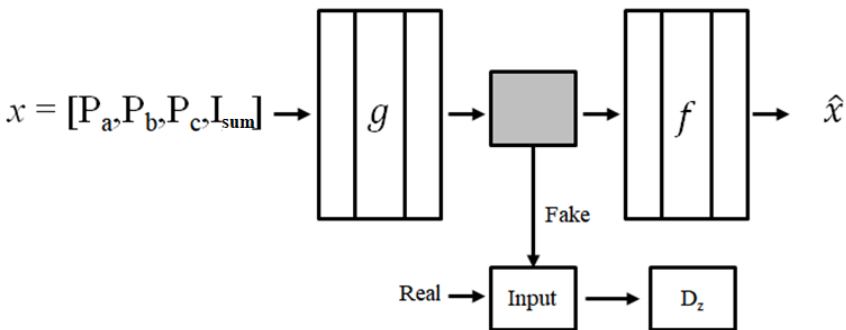
Figure 3. Graphical illustration of the AAE architecture used in this study. The encoder g com- presses the input x and the decoder f reconstructs the input ˆ x . D z acts as a discriminator through learning process.